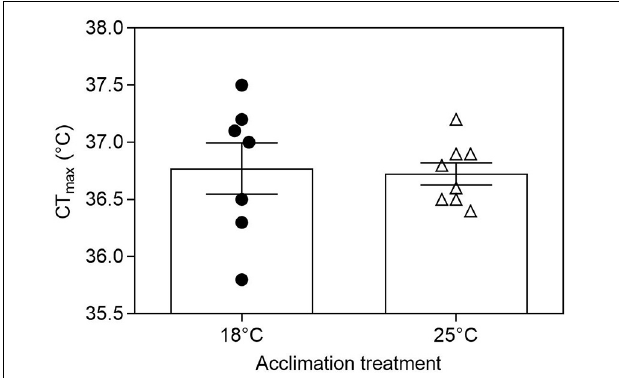
FIGURE 2 | Critical thermal maxima (CT max ) for tadpoles of Bokermannohyla ibitiguara . Acclimation treatment (18 and 25 ◦ C) did not affect CT max of premetamorphic tadpoles ( P = 0.84). Data are presented as mean ± s.e.m. (18 ◦ C, N = 7; 25 ◦ C, N = 8).